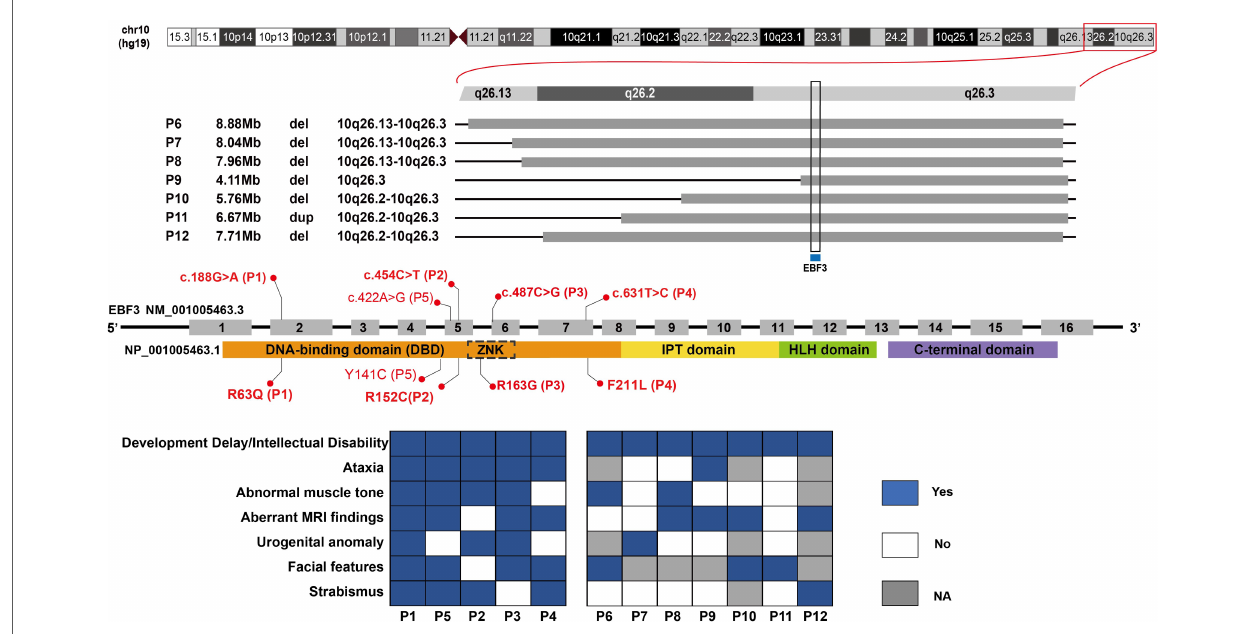
FIGURE 1 EBF3 gene variations and clinical phenotypes of patients in our study. Five single nucleotide variants are shown along the EBF3 gene structure in the middle; the base changes are shown above the EBF3 exon-intron structure and the corresponding amino acid changes are shown below the protein domains. The bold red ones are novel, and the normal red one is reported. The chromosome structure and the seven copy number variants are shown above the gene structure. The genotype-phenotype correlation is shown below the gene structure. A blue square box indicates that the patient has the phenotype, a white square box indicates that the patient does not have the phenotype and a gray square box indicates that the patient ’ s phenotype is not